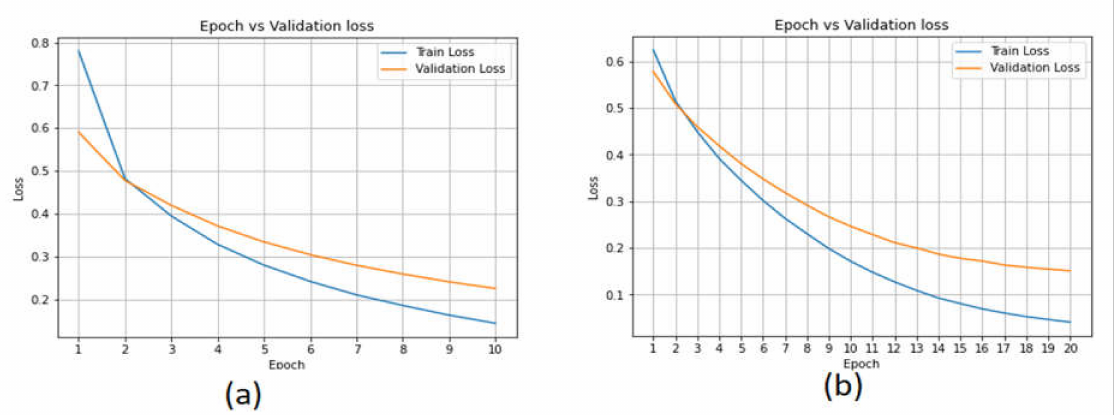
Figure 14. Accuracy loss of the deep learning models in the CICAndMal2017 dataset. ( a ) LSTM. ( b ) CNN-LSTM.